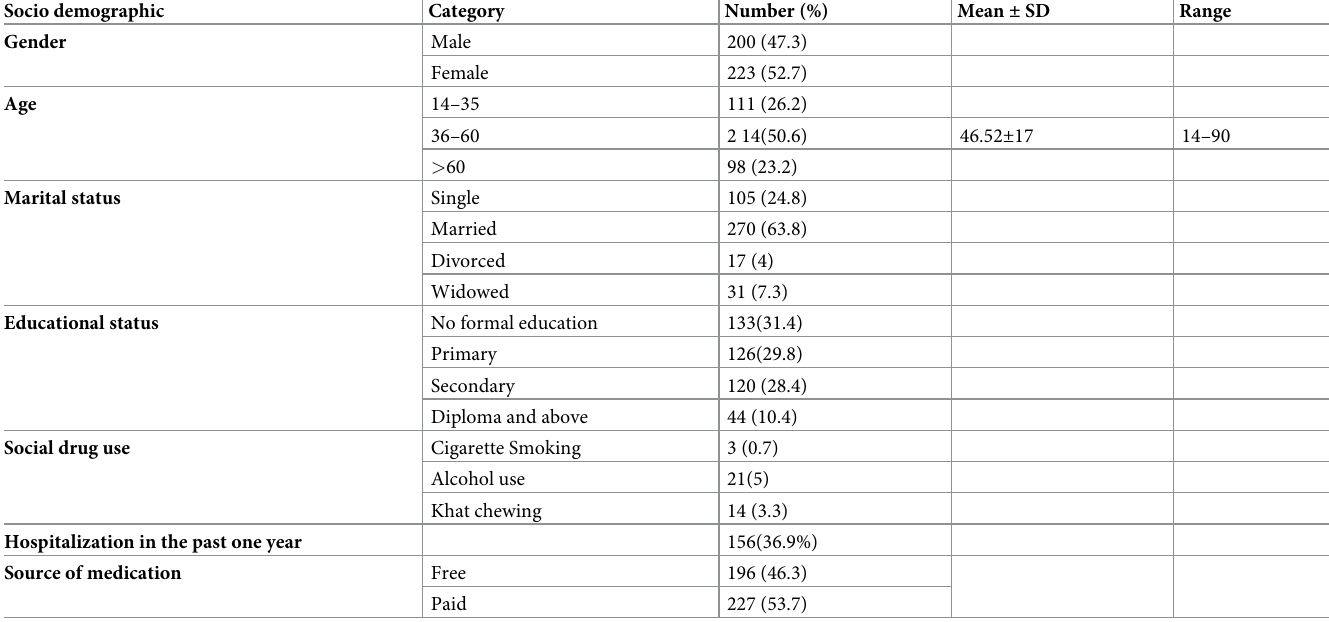
Table 1. Socio-demographic characteristics of heart failure patients attending at the cardiac clinic of Tikur Anbessa Specialized Hospital, Addis Ababa, Ethiopia, June—August, 2017. Socio demographic